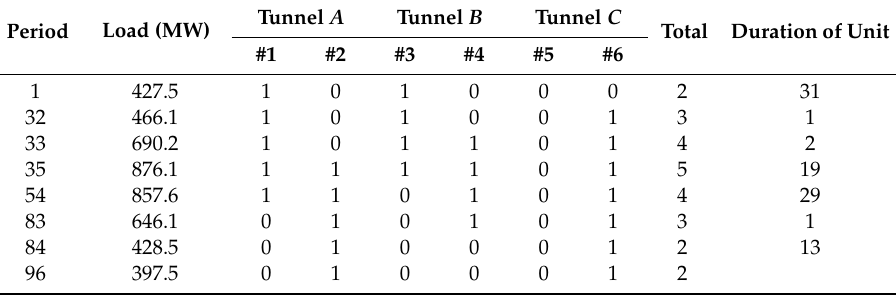
Table 5. Unit state in dry season with high-rate load.